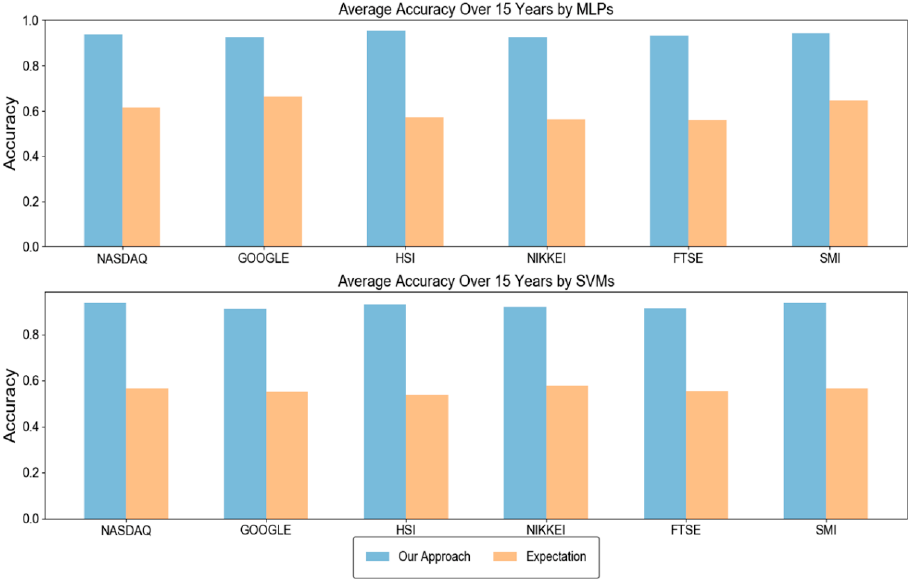
Figure 3. Average accuracy comparison over 15 years.